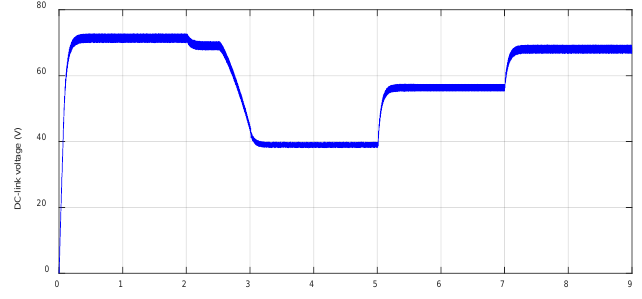
Figure 12. DC-link voltage.